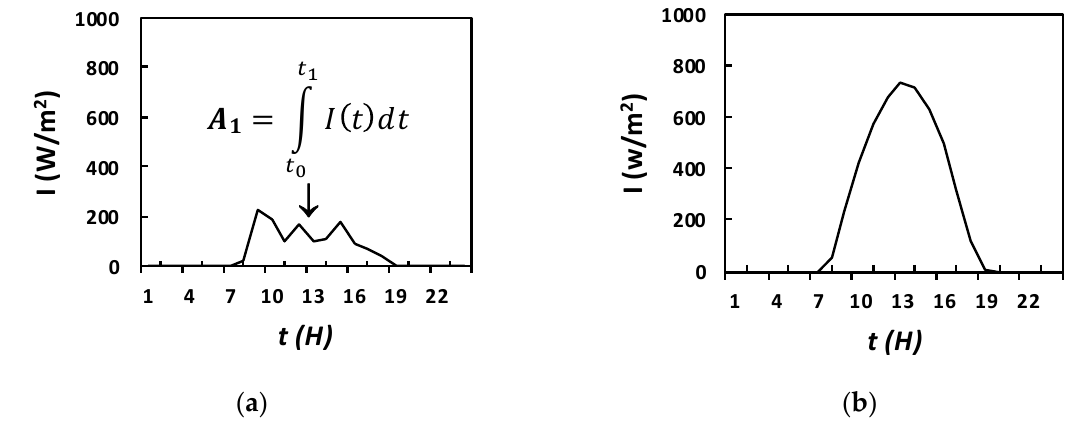
Figure 1. Curves of hourly mean Direct Normal Irradiance (DNI) projected on the horizontal plane for two different days: ( a ) partially cloudy sky and ( b ) clear sky day. A is the area under the curve corresponding to the measured DNI (energy per unit area) and is obtained by numerical integration using the trapezoid rule.